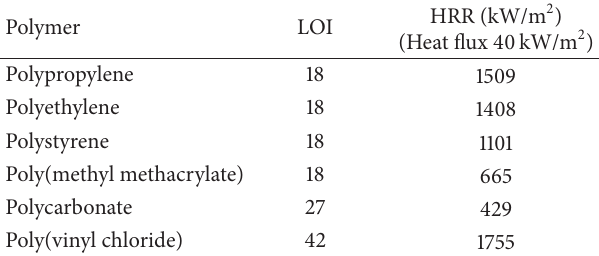
Table 3: Thermal behavior of kenaf/PLA composites [49].